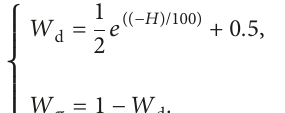
Figure 4: Flow chart of CTSFA